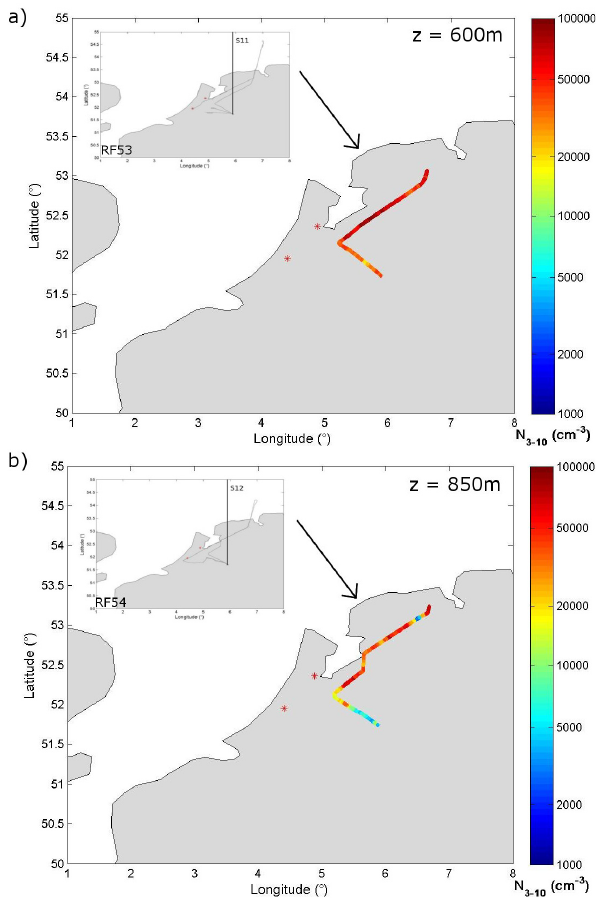
Fig. 4. As for Fig. 3 for Group II events (a) research flights RF43 on 5 May, and (b) RF48 on 11 May.